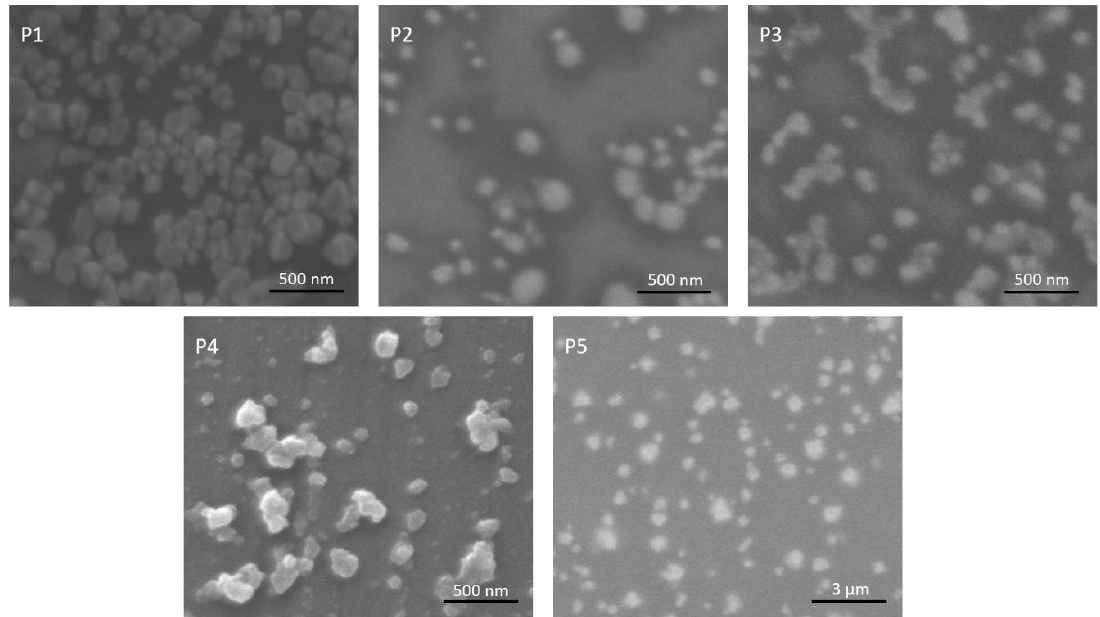
Figure 3. SEM images of the polyplexes at the different formulations. Average diameter and polydispersity index ( PDI ) was calculated from SEM images of the samples.